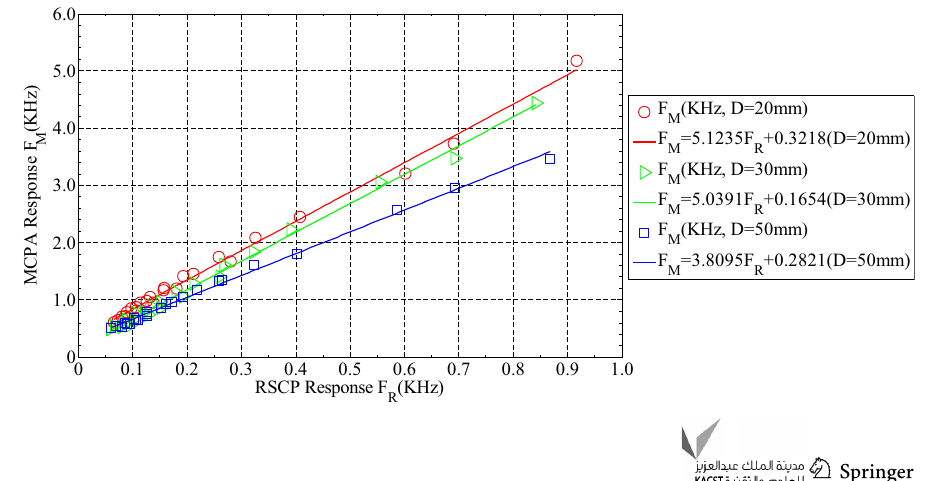
Fig. 15 Relation curves of experiment results with between MCPA with three different inner diameters and RSCP under the conditions of 𝜌 w ∈ ( 0.5 g l − 1 ,7.5 g l − 1 ) and